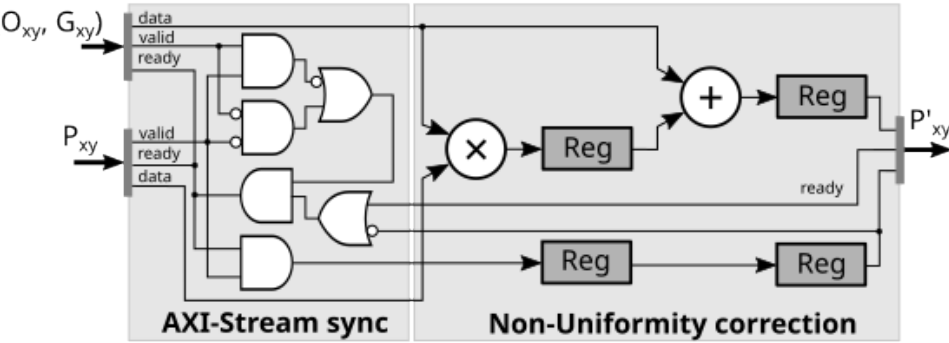
Figure 4. Non-uniformity correction implementation.